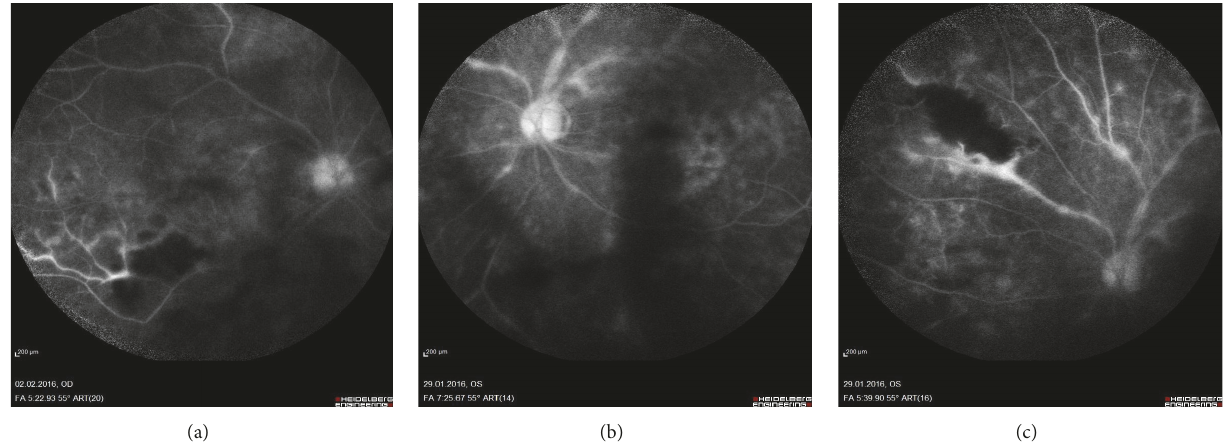
Figure 2: (a) RE, blockage of choroidal fluorescence secondary to vitreous opacities, pronounced ischemic areas in inferotemporal arcade, collateral vessel formation, and leakage near the optic nerve head and along the retinal veins. (b,c) LE, blockage of choroidal fluorescence secondary to vitreous opacities, leakage in foveal area along the retinal vessels, and staining of nasal retinal veins.